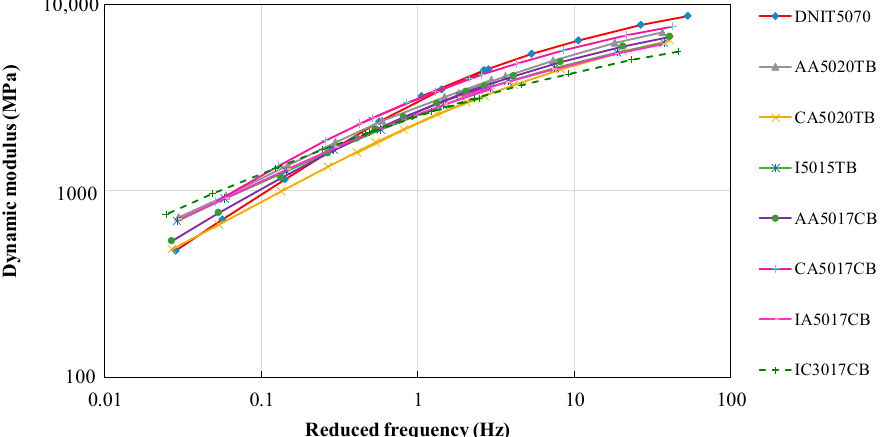
Figure 5. Master curves of dynamic modulus for a reference temperature of 20 °C.